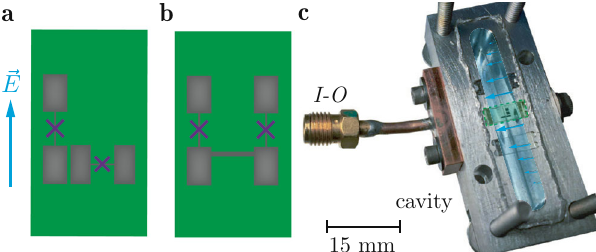
Fig. 5 Two – qubit, one-cavity devices. a , b Not-to-scale diagram illustrating chip con fi gurations A and B, respectively. Vertical blue arrow indicates cavity electric fi eld orientation. Crosses mark the location of Josephson tunnel junctions. c Optical photograph of sample R2C1. Bottom half of aluminum sample holder is visible; top half is removed. The two-qubit chip (outlined by the dashed green box) is housed in the middle of the readout cavity (highlighted in blue). Cavity fundamental mode electric fi eld pro fi le E depicted by arrows. Input-output SMA pin coupler labeled I-O . , bare m